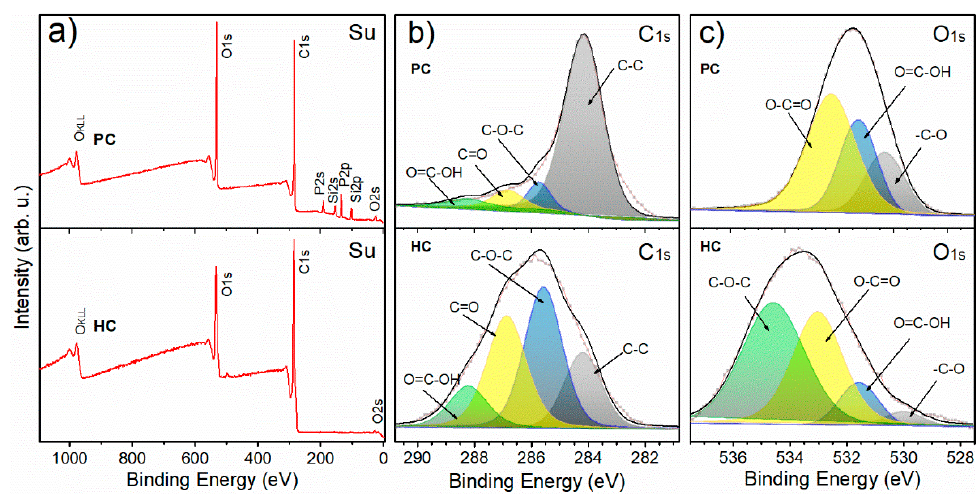
Figure 4. ( a ) Survey acquisition presenting the atomic concentration, ( b ) high resolution XPS C1s Core level of PC and HC samples, and ( c ) deconvolution of O1s. Core level of PC and HC samples, and ( c ) deconvolution of